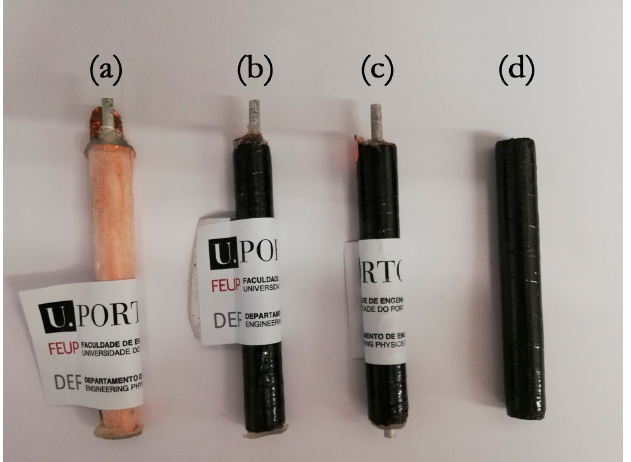
Figure 4. Showcase of the type of coaxial cells and parts investigated; ( a ) structural battery with